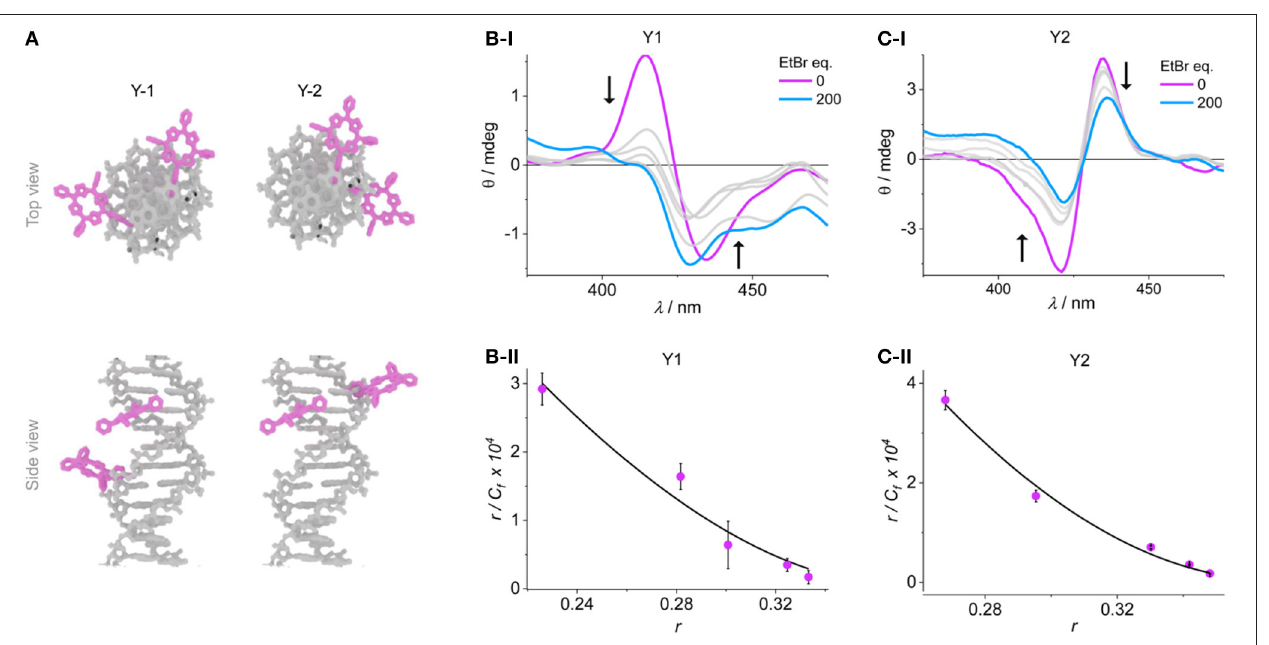
Frontiers in Chemistry |